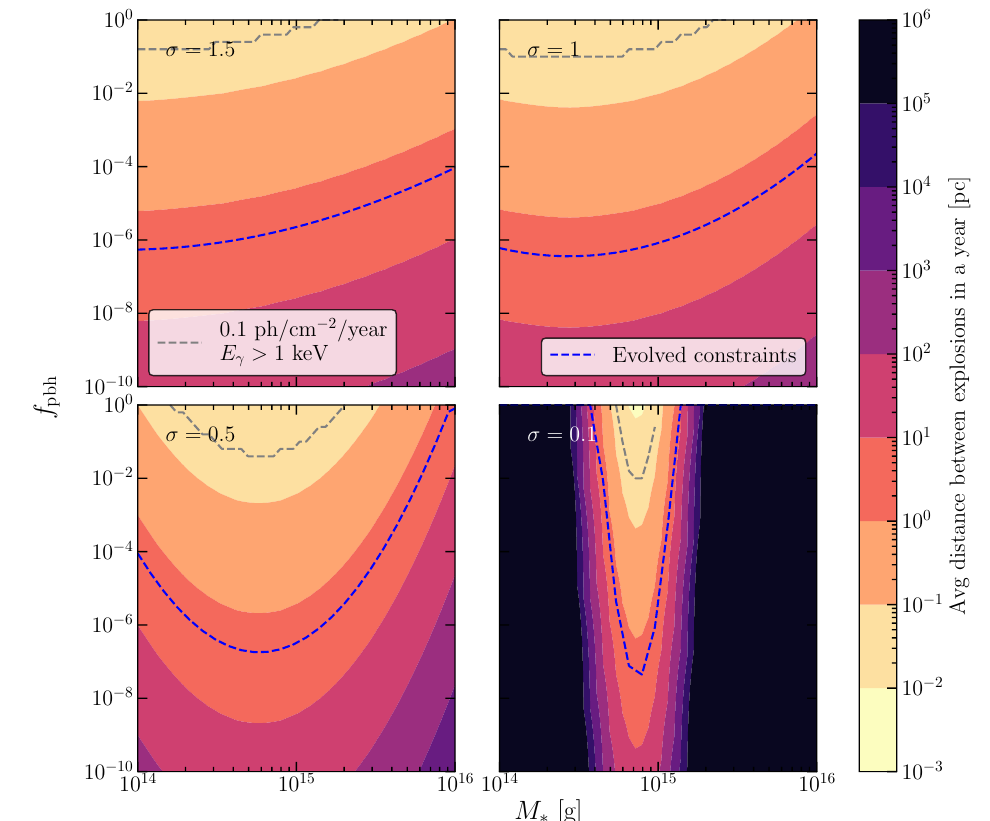
Figure 6: The average distance between black hole explosions for evolved dis- tributions with varying central mass M ∗ and four values of σ . The dotted grey line gives the distance that would correspond to a observed photon flux of 0.1 photons cm − 2 yr − 1